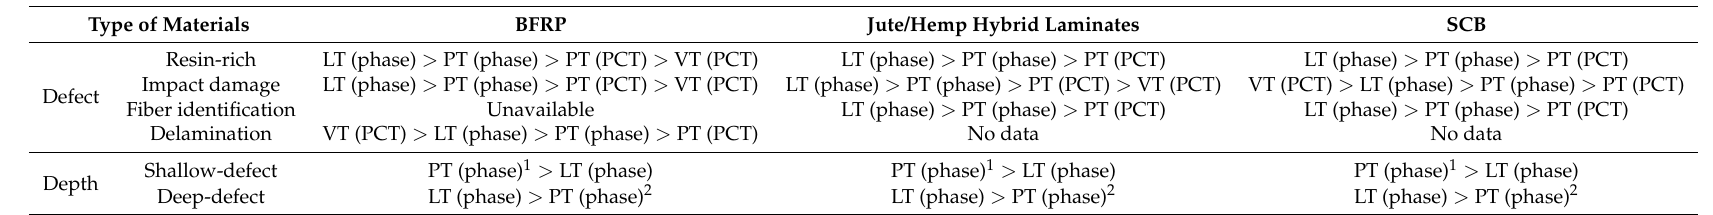
Table 8. Capabilities of different thermographic